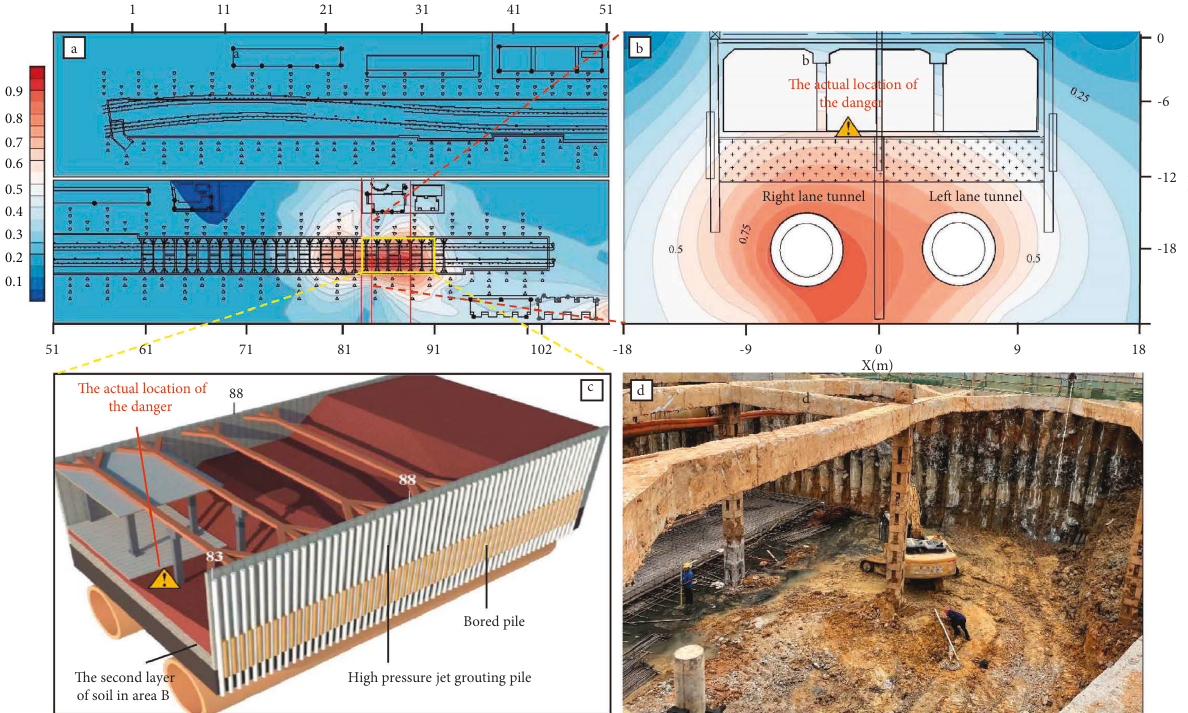
Figure 13: Comparative analysis of the second risk assessment and the actual situation: (a) risk distribution assessment plan; (b) risk distribution assessment sectional view; (c) construction status and actual location of the accident at the time of the second accident; (d) the scene of the second accident.